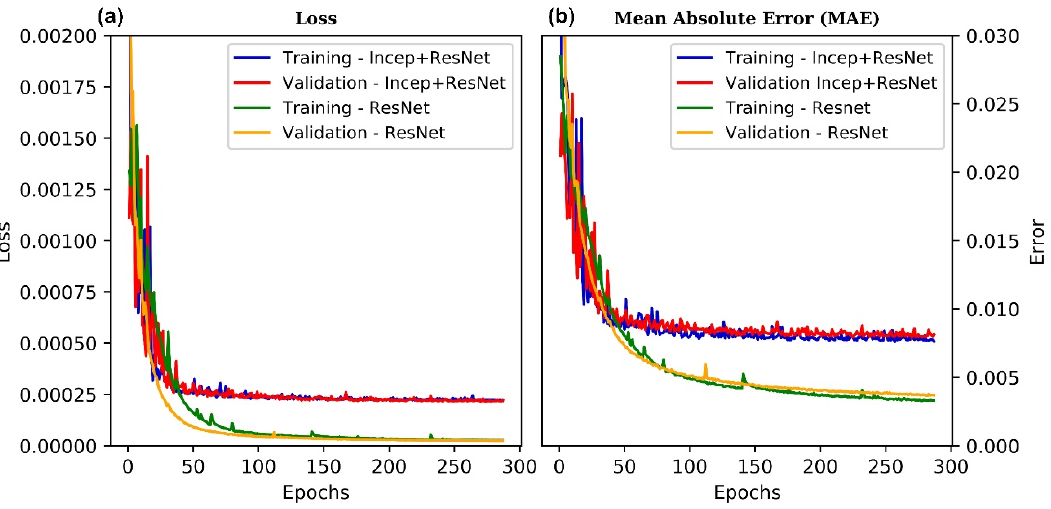
Figure 8. The training and validation metrics for both the ResNet and inception-ResNet models: ( a ) training and validation loss; ( b ) training and validation mean absolute errors.